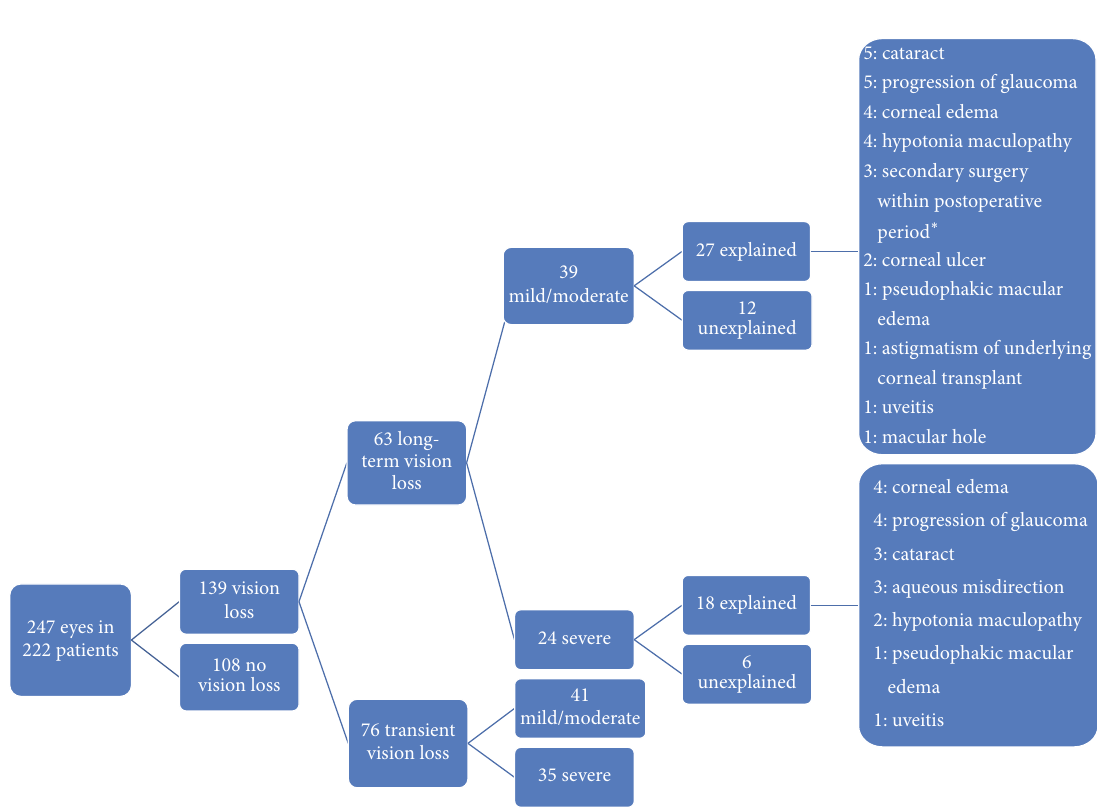
Figure 1: Incidence of vision loss among 247 eyes in 222 patients six months after Baerveldt glaucoma tube shunt implantation.